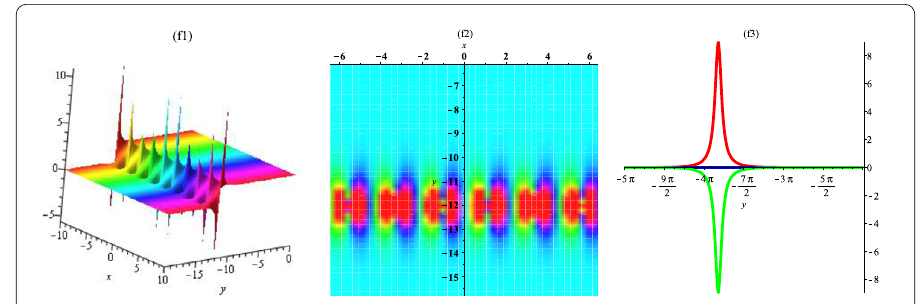
Figure 12 For solution of (3) u , v , w , c i = 0, t = 1, z = 10, (f1) 3D plot (f2) density plot and (f3) 2D plot with spaces x =